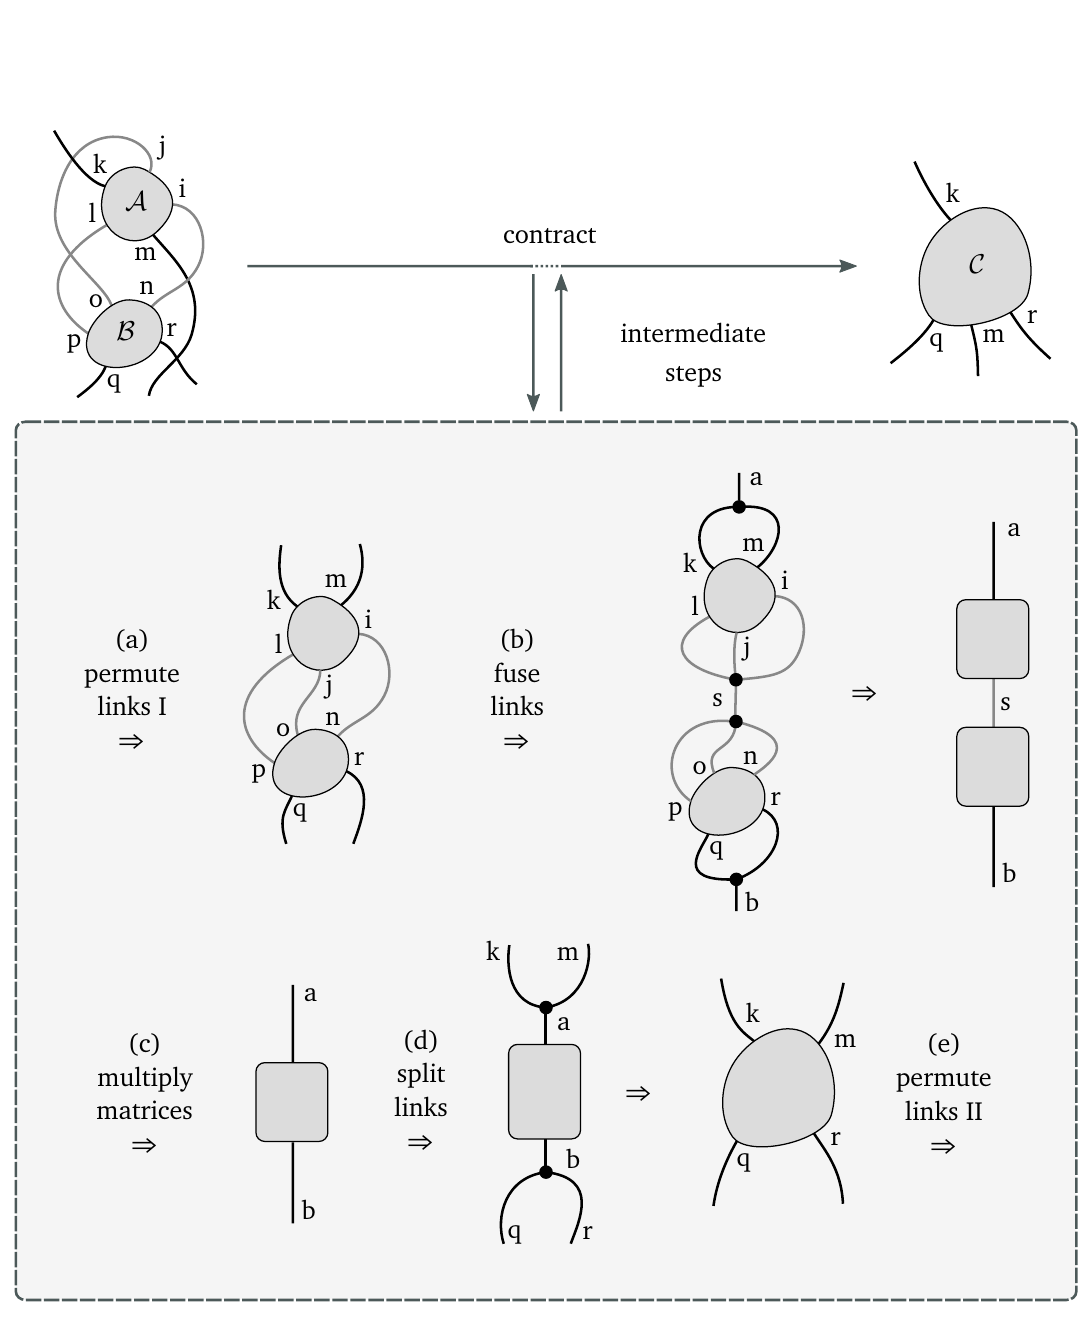
Figure 7: Intermediate steps in the contraction of two tensors, realized through matrix-multiplication. First, the input tensors A and B are brought into correct matrix-shape, which in general involves (a) permuting and (b) fusing their links. After their matrix-multiplication (c) is carried out, the remaining original links are restored into the expected order by a final (d) splitting and (e) permutation operation. Those permutation, fuse- and split-steps are very common among tensor-operations that rely on matrix-operations